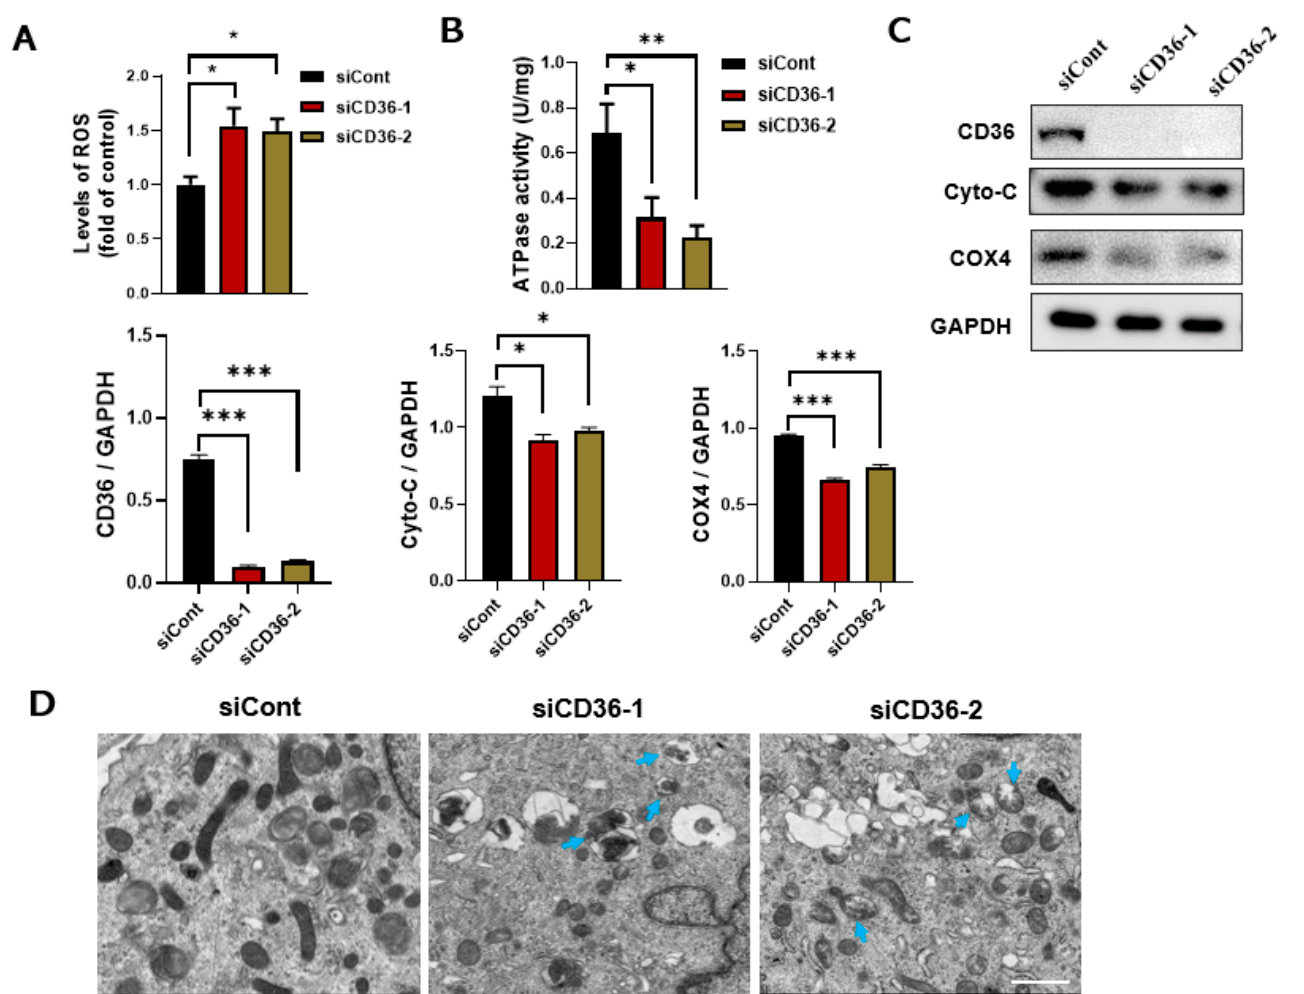
Figure 3. Loss of CD36 induces mitochondrial dysfunction in C2C12 myotubes without PA loading. ( A ) ROS content. ( B ) ATPase activity. ( C ) Western blot analysis and quantification of Cyto-C and COX4 protein expression in differentiated C2C12 cells after transfection with siCont or siCD36. ( D ) Ultrastructure changes in the mitochondria shown via electron microscopy in differentiated C2C12 cells after transfection with siCont or siCD36. Blue arrows indicate the injured mitochondria, (scale bar, 10 μ m). Values are presented as the mean ± SEM of three independent experiments. * p < 0.05, ** p < 0.01, *** p < 0.001 versus the siCont group.